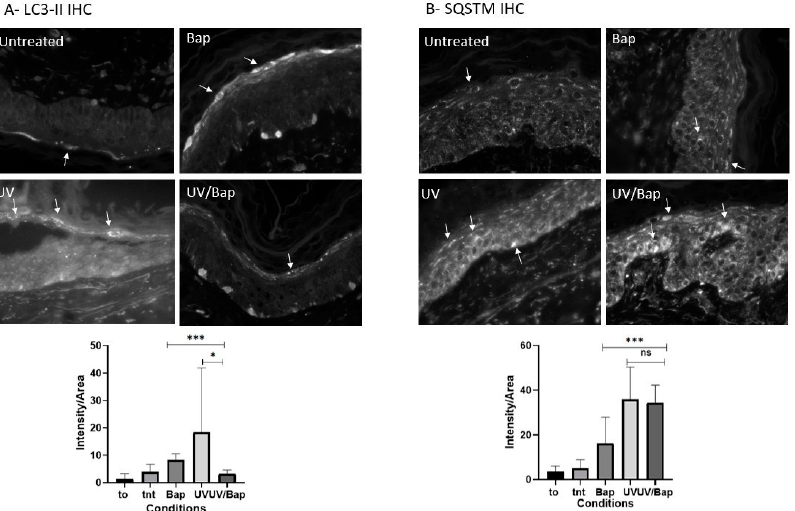
Figure 3. Immunohistochemistry of skin explants for autophagy markers LC3-II and SQSTM. Seven days post the different treatments, either sham treated or exposed to UV and/or Bap, the staining of autophagy markers was conducted on the explants. ( A ) LC3-II staining; an increase in LC3-II puncta was detected upon the exposure of the samples to either UV or Bap compared to the untreated samples. Moreover, an increase was also detected for samples treated with both UV and Bap, but this was less prominent when compared to each treatment alone. ( B ) SQSTM staining; all of the different treatments displayed an increase in SQSTM staining, signifying a failure to eliminate autophagosomal aggregates. Examples of puncta are pointed out by arrows. To: explant on Day 0, tnt: untreated, Bap: Benzo[a]pyrene exposed, UV: UV irradiated, UV/Bap: UV irradiated and Benzo[a]pyrene exposed explant, *: p < 0.05, ***: p < 0.001, ns: non significant, 400× magnification (Obj. 40×).